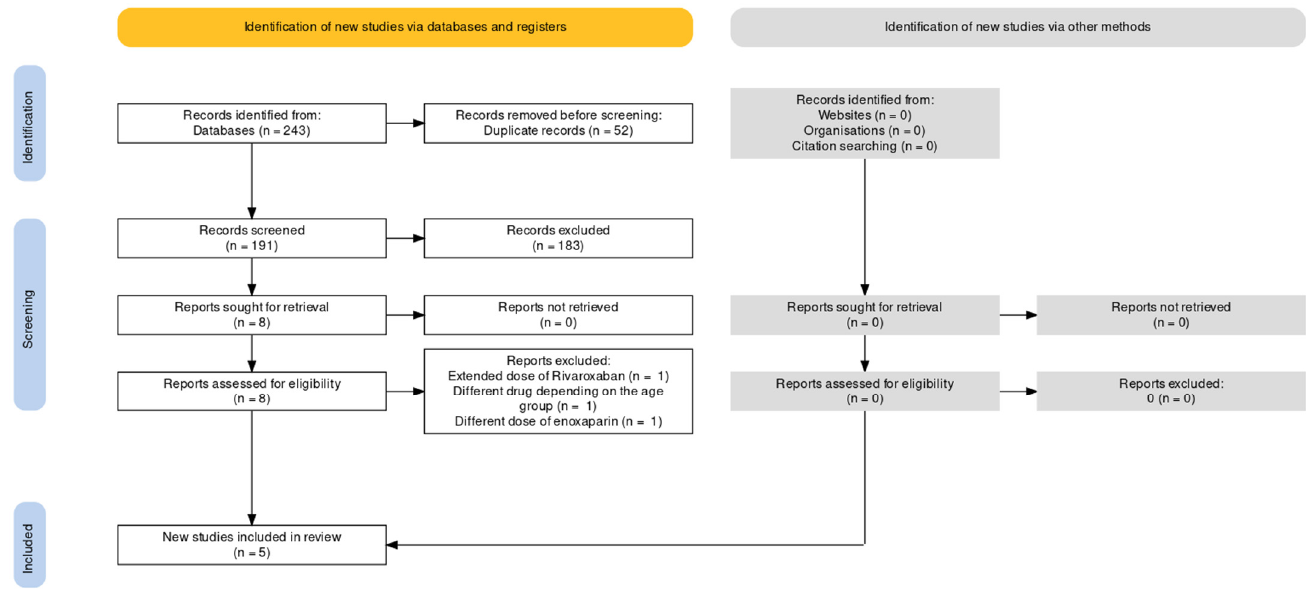
Figure A1. Flowchart for study selection according to the Preferred Reporting Items for Systematic Reviews and Meta-Analyses Guidelines.